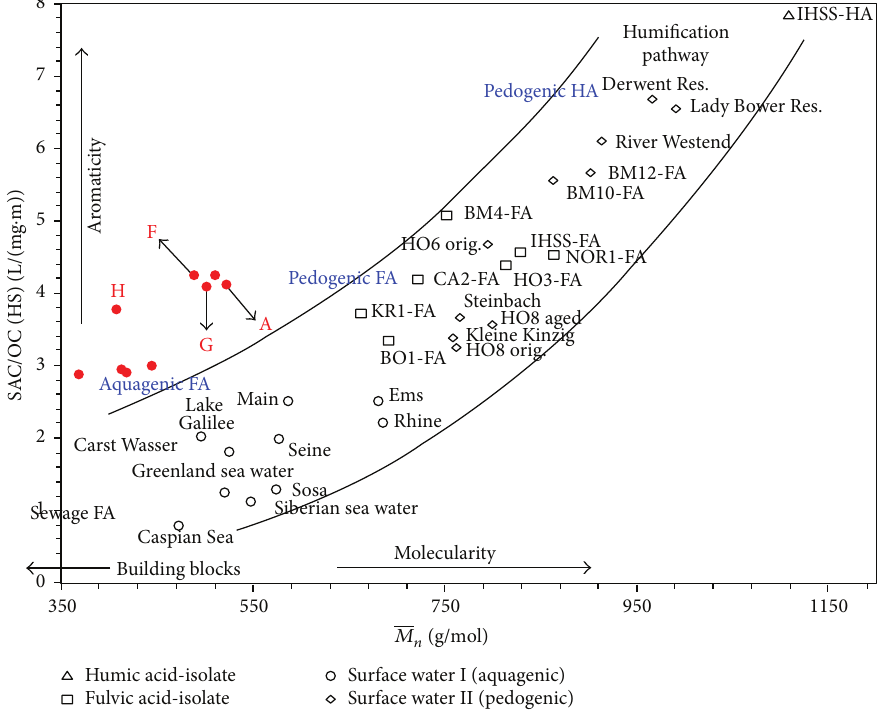
Figure 4: The aromaticity-molecularity relationship presented on a HS diagram. A represents raw water from the Vaal River, F represents raw water filtered through silica, G represents raw water filtered through X SPE, and H represents water filtered through C-18 SPE. HS diagram presented here reveals the aromatic character ( 𝑥 -axis) of NOM fractions as a function of their molecular weights ( 𝑦 -axis). This diagram plots the spectral absorption coefficient (SAC) to the organic carbon (OC) ratio (aromaticity) of a HS fraction against its nominal molecular weight ( 𝑀 𝑛 )